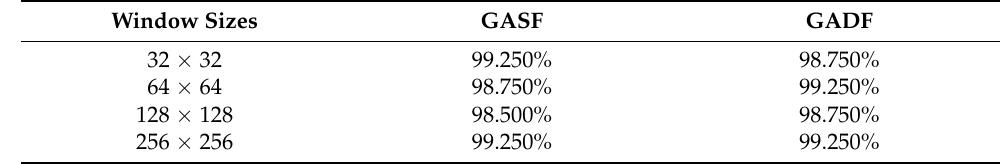
Table 1. The identification accuracy of validation datasets with different window sizes.